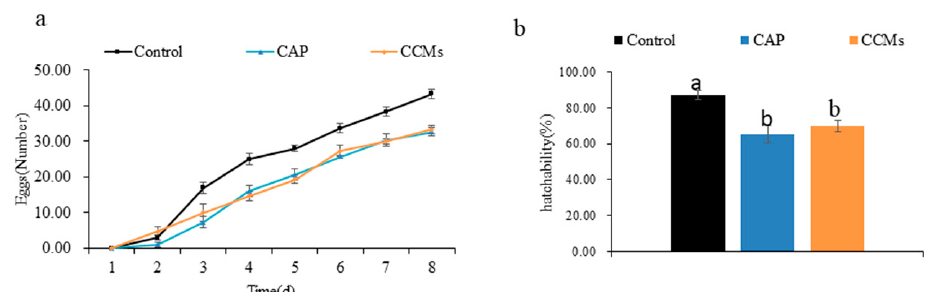
Figure 4. Effect of the CAP containing agents on the T. castaneum oviposition ( a ) and hatching ( b ). Data are expressed as mean ± SD ( n = 3); values followed by different letters were significantly different by Tukey’s multiple range test. The one-way ANOVA result was df = 2, F = 20.394, p < 0.05.